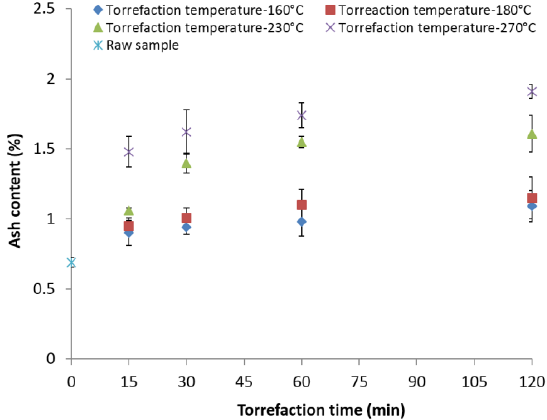
Figure 6. Ash content in ground lodgepole pine with respect to the torrefaction temperature and time.